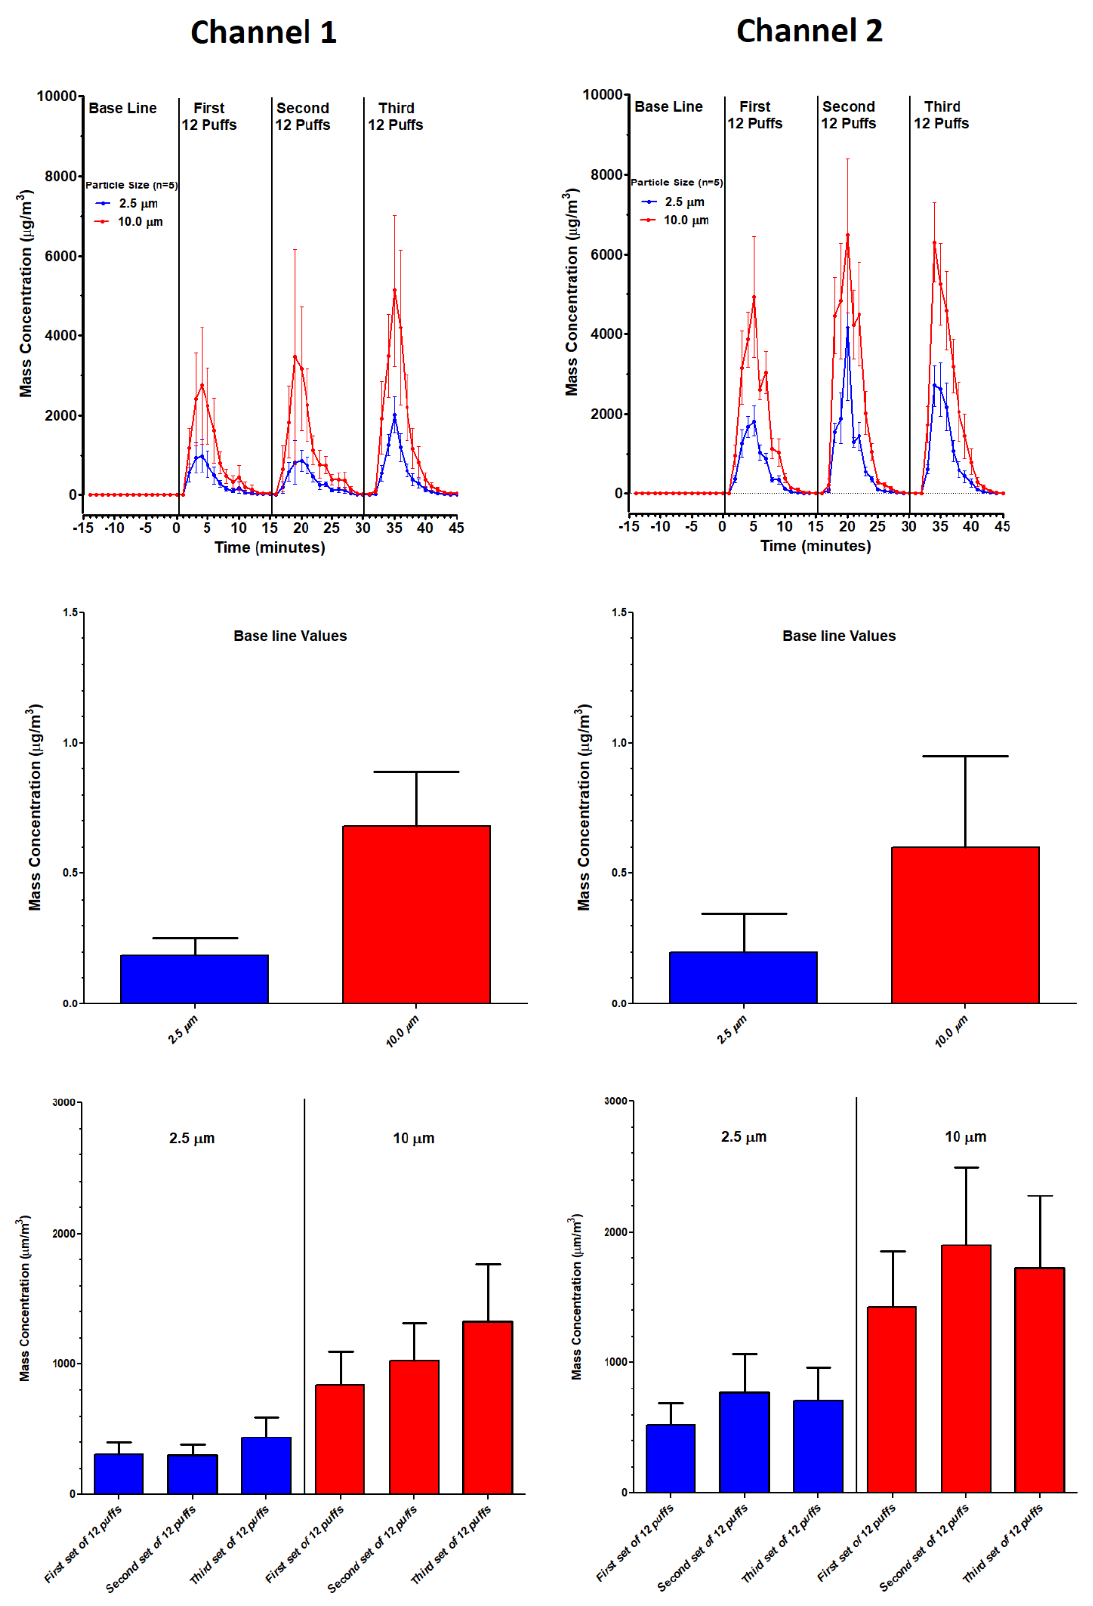
Figure 9. Profiles of mass concentrations ( upper panels ), average baseline mass concentrations ( middle panels ) and average mass concentrations for each of three sets of twelve puffs ( lower panels ) of the ECIG aerosol generator running both channels simultaneously. Each bar represents the mean ± SEM (n = 15).